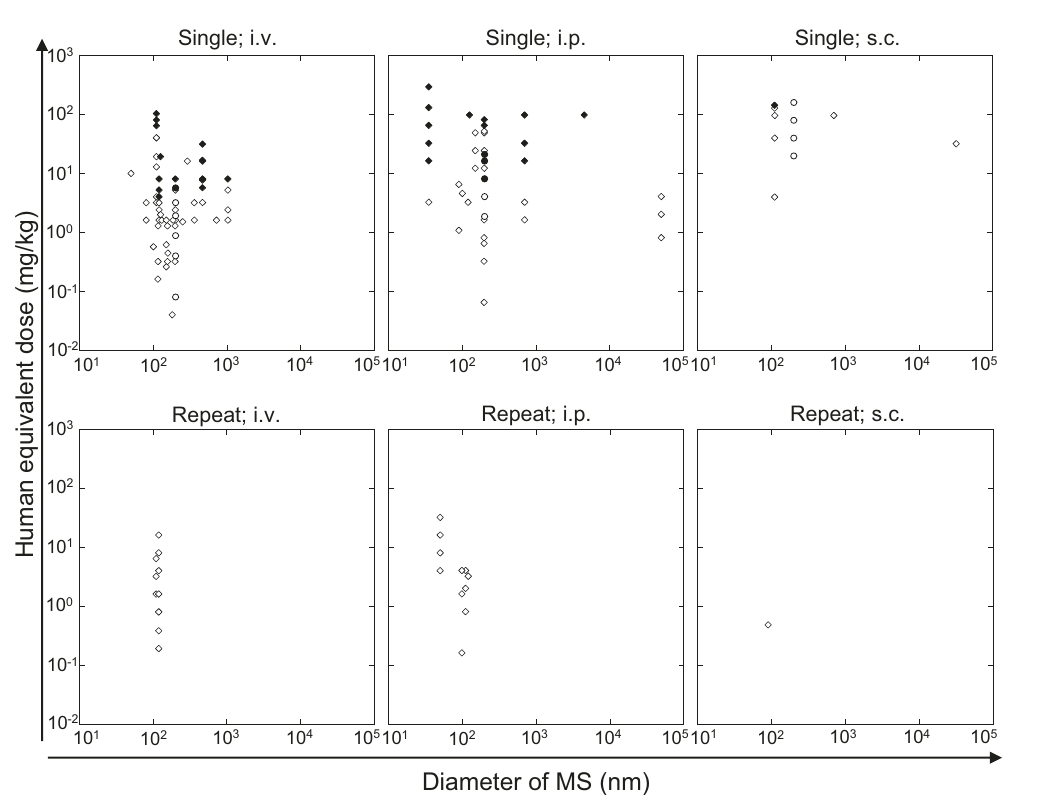
Fig. 7 Integrated mesoporous silica lethality with different adminis- tration routes acquired by the combination of the experimental and literature studies. Open symbol: no animal death; fi lled symbol: at least